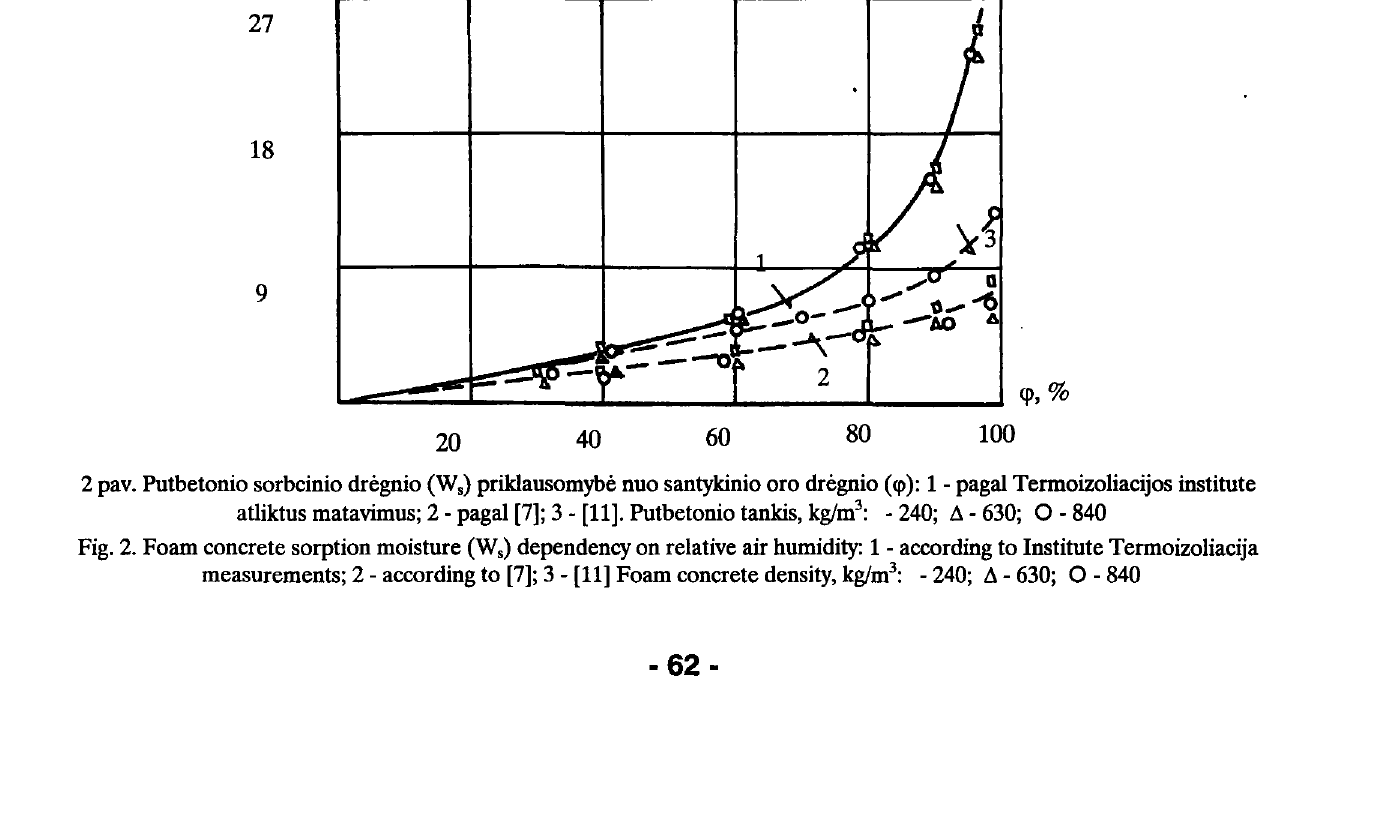
Fig. 2. Foam concrete sorption moisture (W.) dependency on relative air humidity: 1 - according to Institute Termoizoliacija measurements; 2 - according to [7]; 3 - [11] Foam concrete density, kg/m 3 : - 240; ll - 630; 0 -